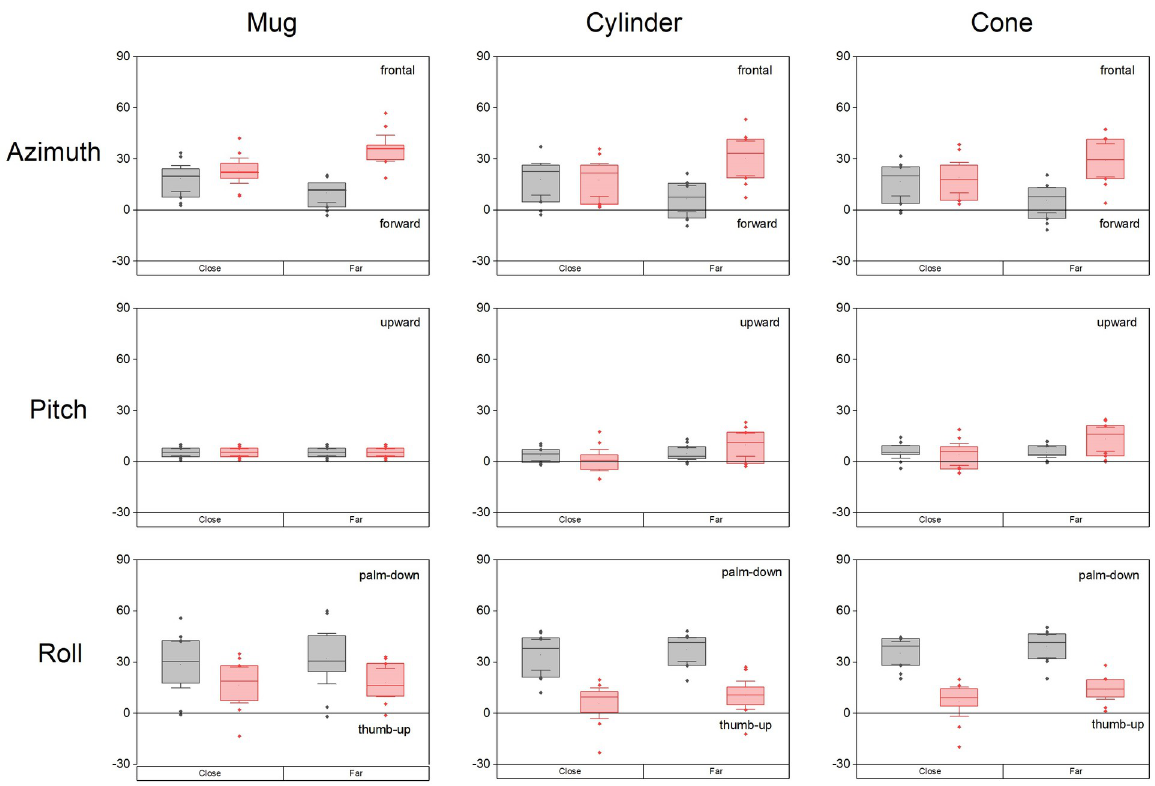
Fig 7. Euler angles describing hand orientation at the time of grasping for the three objects. Same legend as Fig